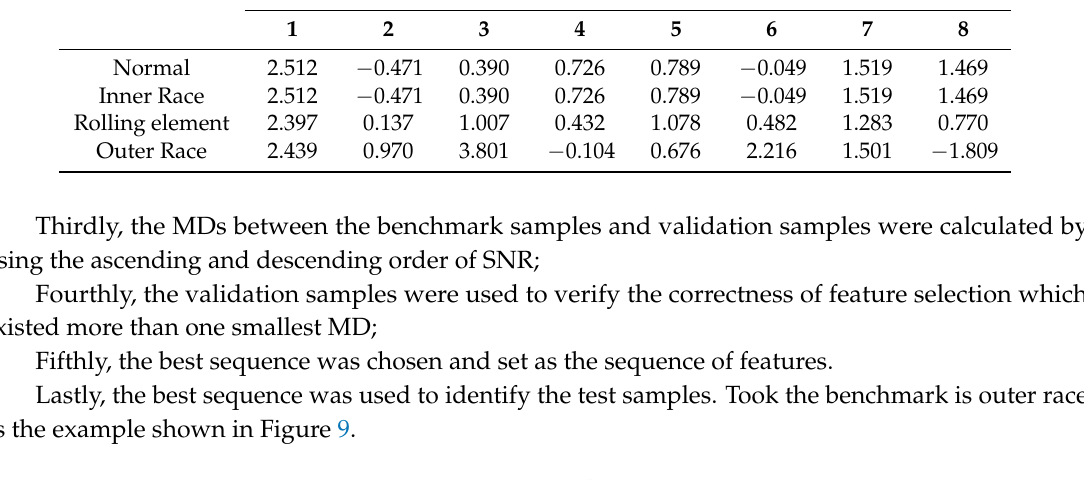
Table 6. The signal-to-noise ratio (SNR) gain of features.